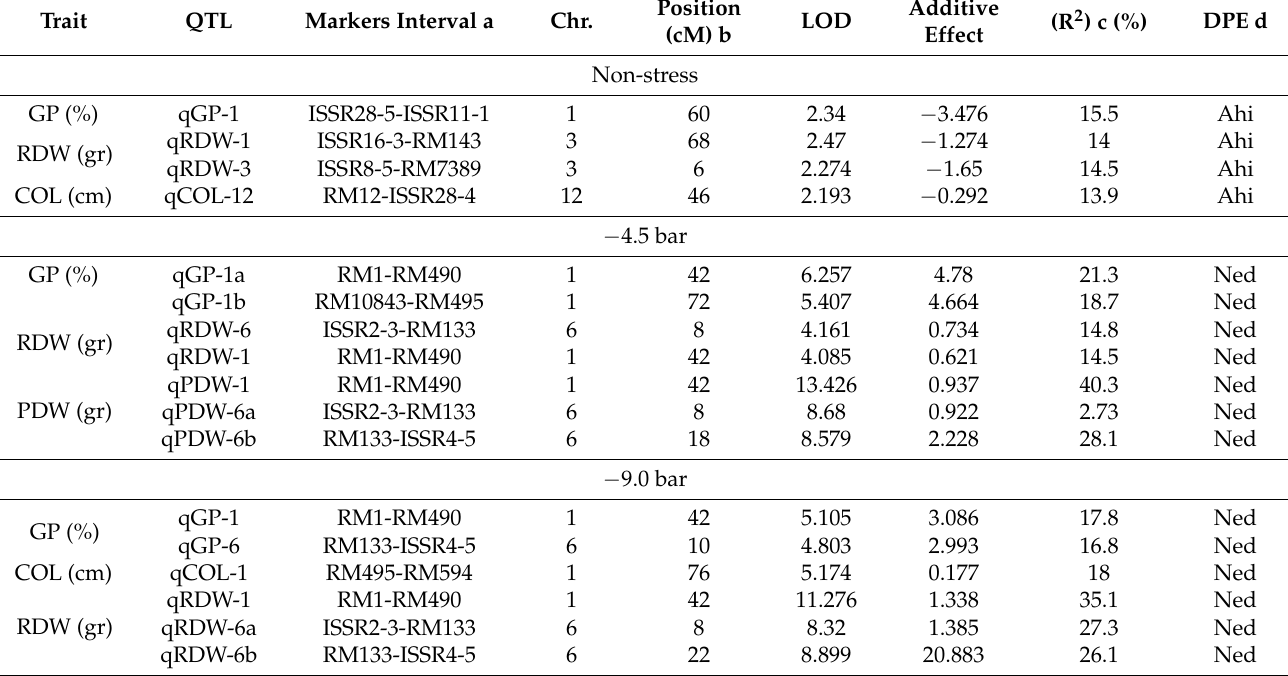
Table 3. Control QTLs for the studied traits at the germination stage under normal